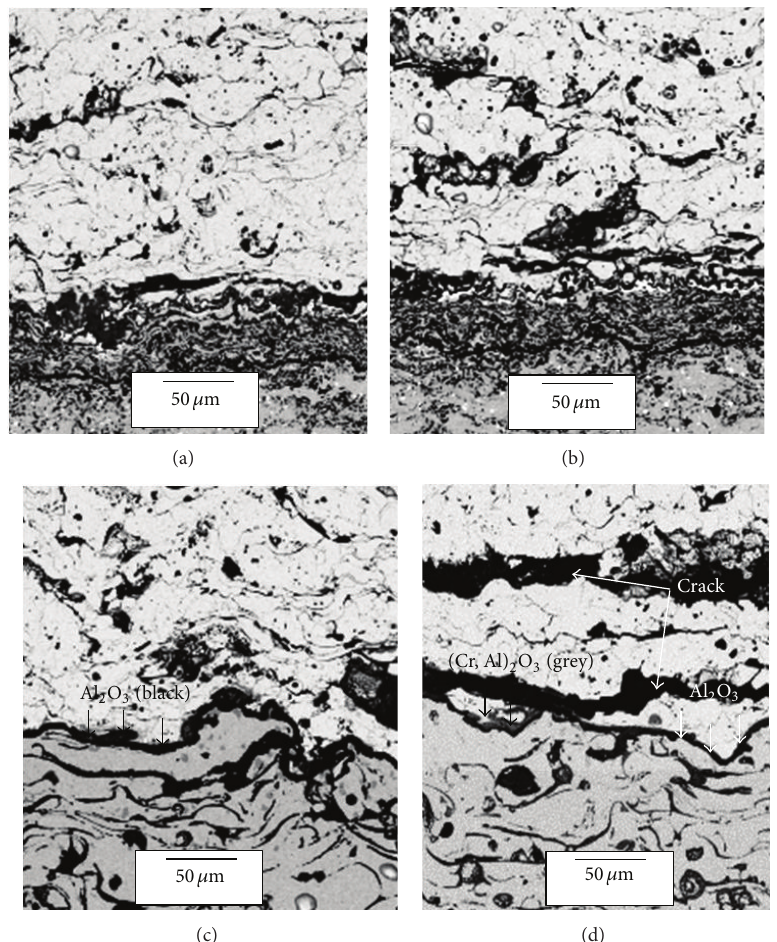
Figure 3: Highly magnified microstructures at the interfaces of the top and bond coats in TBCs after cyclic thermal exposure tests for 381 cycles: (a) TBC-A, (b) TBC-B, (c) TBC-C, and (d)